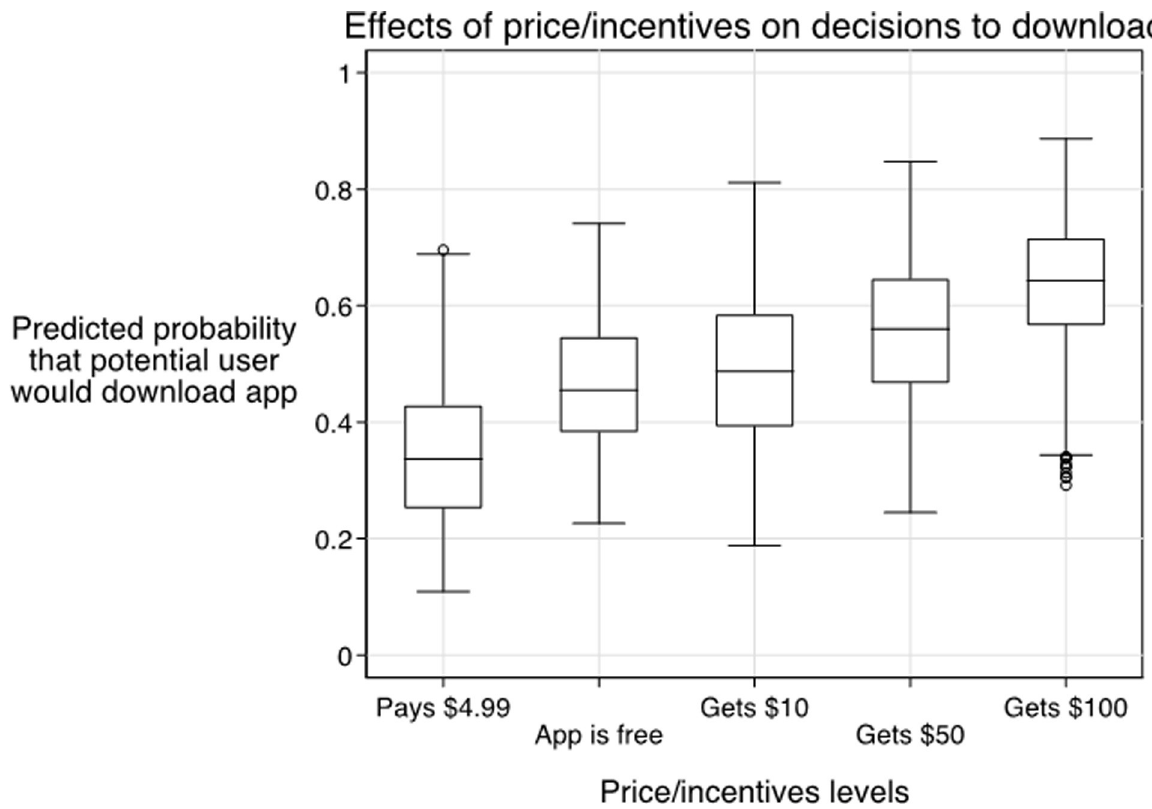
Fig 4. Predicted effects of price/incentives on decisions to download EN apps (n = 394). Notes: We used preference estimates from random parameter logit models (S3 Fig) to predict the probability that a participant would select a given app at different levels of price/incentives. The box plots represent the distributions of these predicted probabilities across